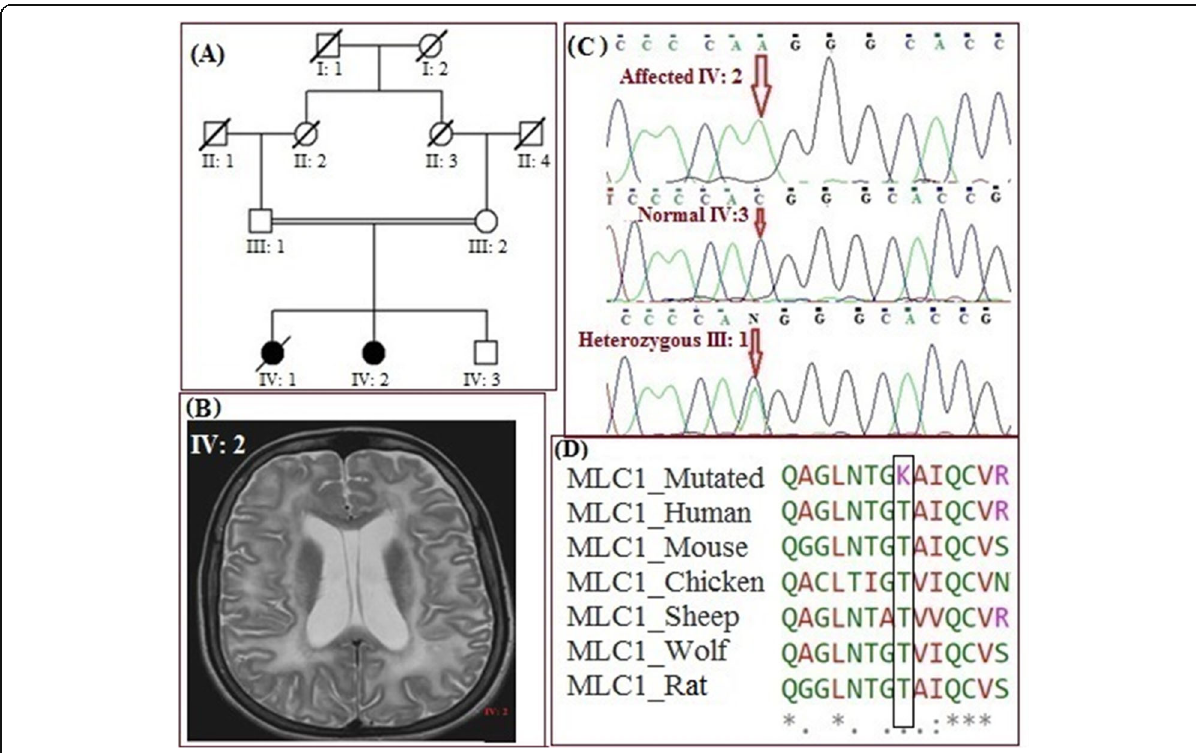
Fig. 3 a Pedigree of the family representing one patient (IV: 2). b Brain MRI of patient showing white matter with subcortical cysts. c Sanger sequencing showing homozygous affected (IV: 2), normal (IV: 3) and heterozygous parent (III: 1). d Multiple alignment of MLC1 showing complete conservation across different